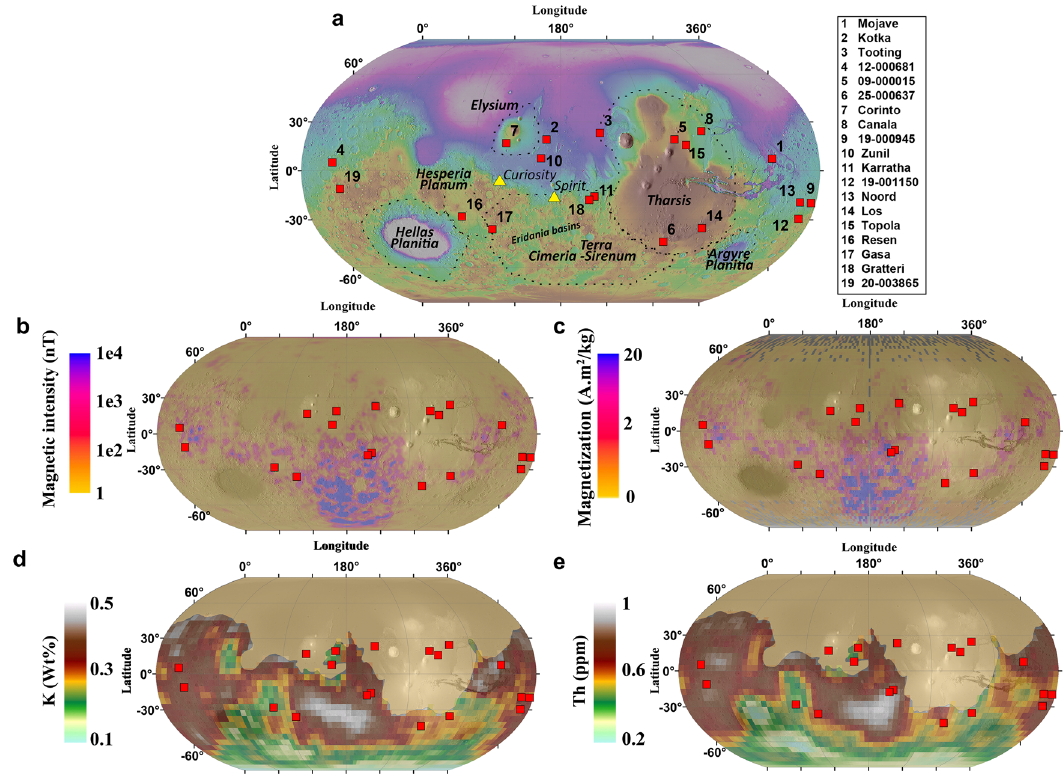
Fig. 2 Distribution of the most likely crater sources for martian meteorites. a Global context of the 19 crater candidates 18 (Supplementary Table 1) and location of provinces and rovers (yellow triangles) referred to in the present study. Background: Mars Orbiter Laser Altimeter (MOLA) shaded relief (https://astrogeology.usgs.gov/search/map/Mars/GlobalSurveyor/MOLA/Mars_MGS_MOLA_DEM_mosaic_global_463m). b , c : Magnetic fi eld intensity and remanent magnetization at the surface from ref. 27 . d , e Potassium and Thorium concentration at the surface from ref. 28,30 . Beige area corresponds to discarded provinces due to the weathered basaltic surface contribution